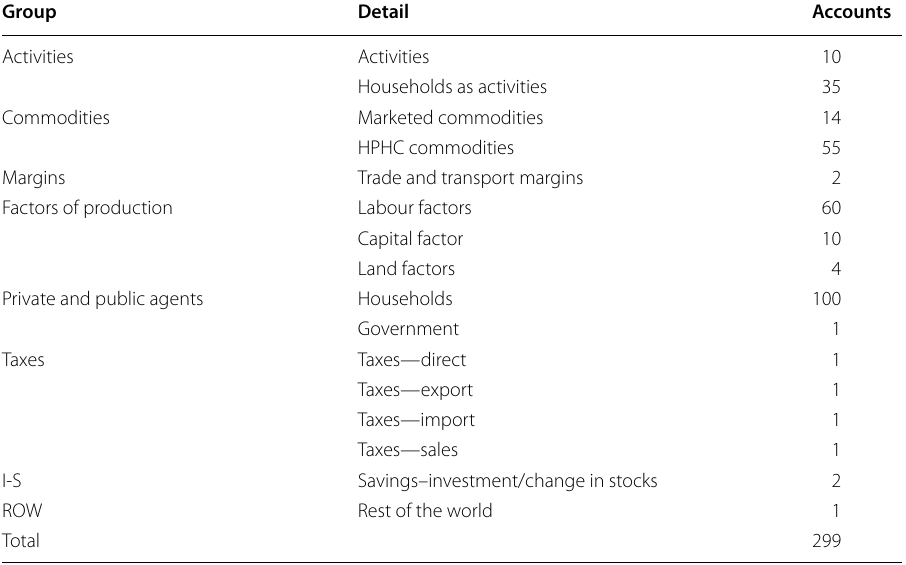
Table 1 Ghana SAM 2015 accounts. Source: own elaboration based on Ferreira et al. (2021)